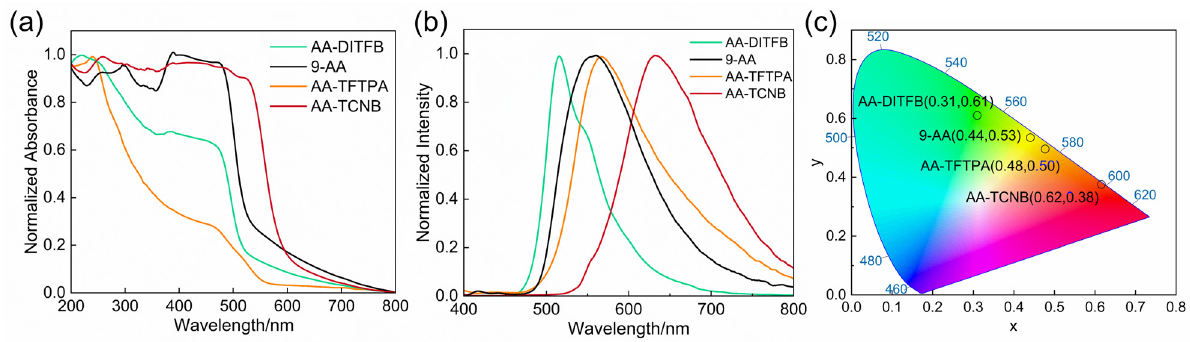
Figure 2. ( a ) Absorption spectra, ( b ) photoluminescence (PL) spectra ( λ ex = 365 nm), and ( c ) chromaticity coordinate according to the CIE 1931 of 9-AA and cocrystals.